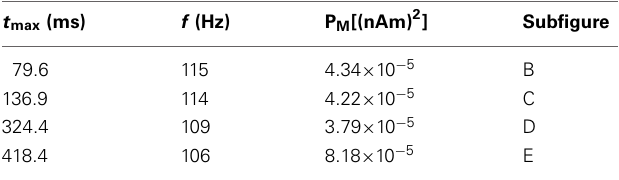
Table 2 | Epochs of high frequency